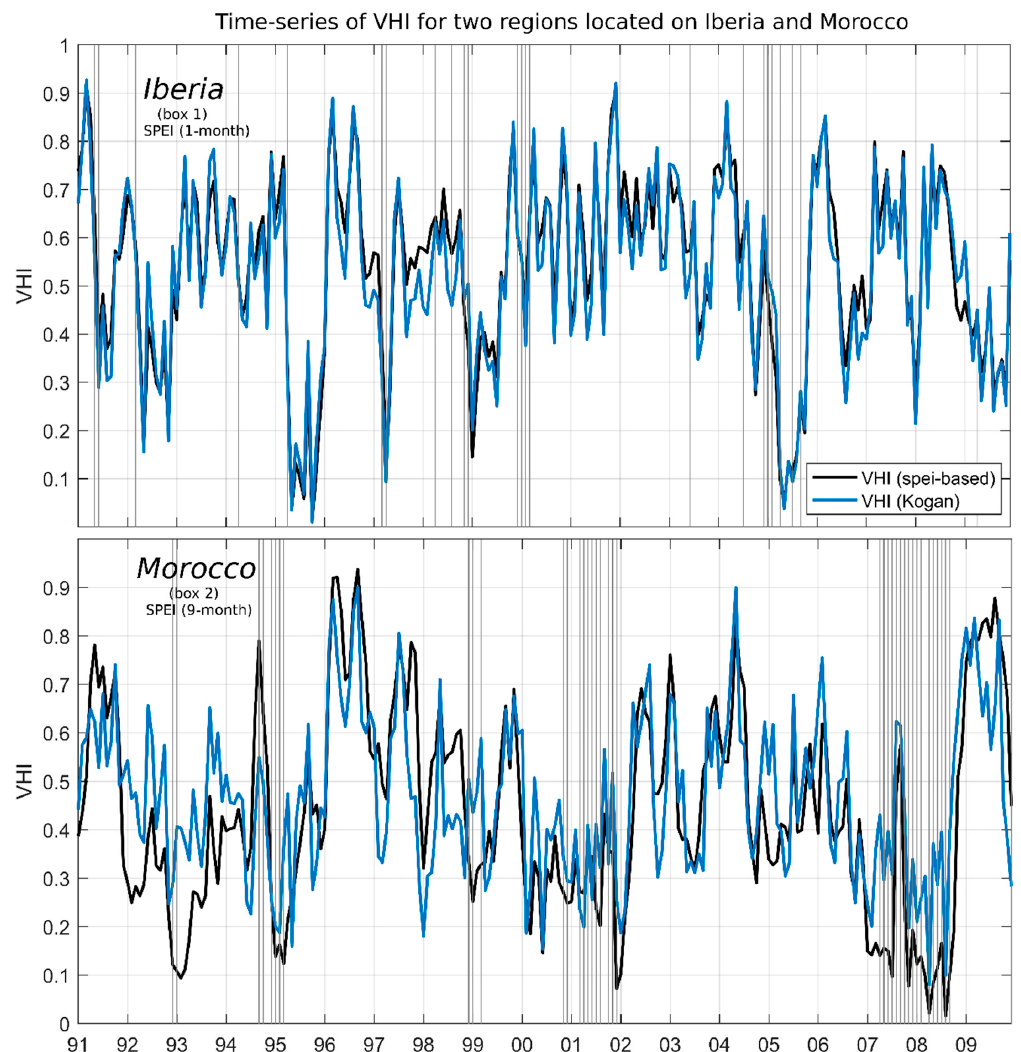
Figure 6. Comparison between time series of VHI estimated with: the traditional method ( α = 0.5) previously introduced by Kogan (blue line); and the SPEI-based method (black line) for the Iberian ( top panel) and Moroccan ( bottom panel) regions. Vertical grey lines in the time-series represent severe drought events as estimated with the dominant time-scale of SPEI in each region: 1-month in Iberia and 9-month in Morocco.